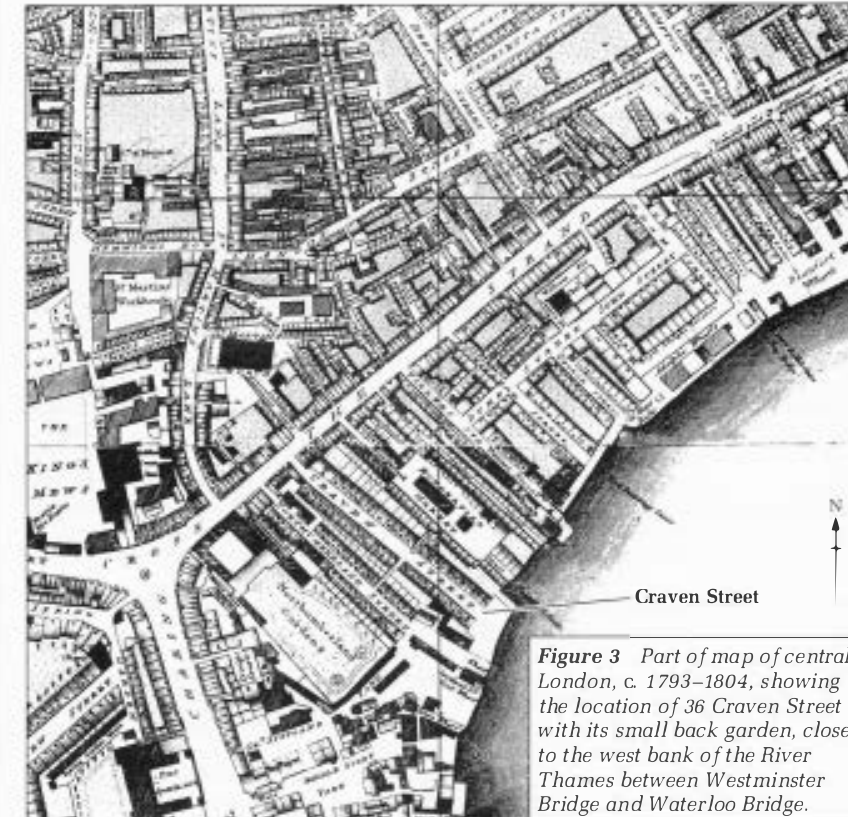
Figure 3 Part of map of central London, c. 1 793-1804, showing the location of 36 Craven